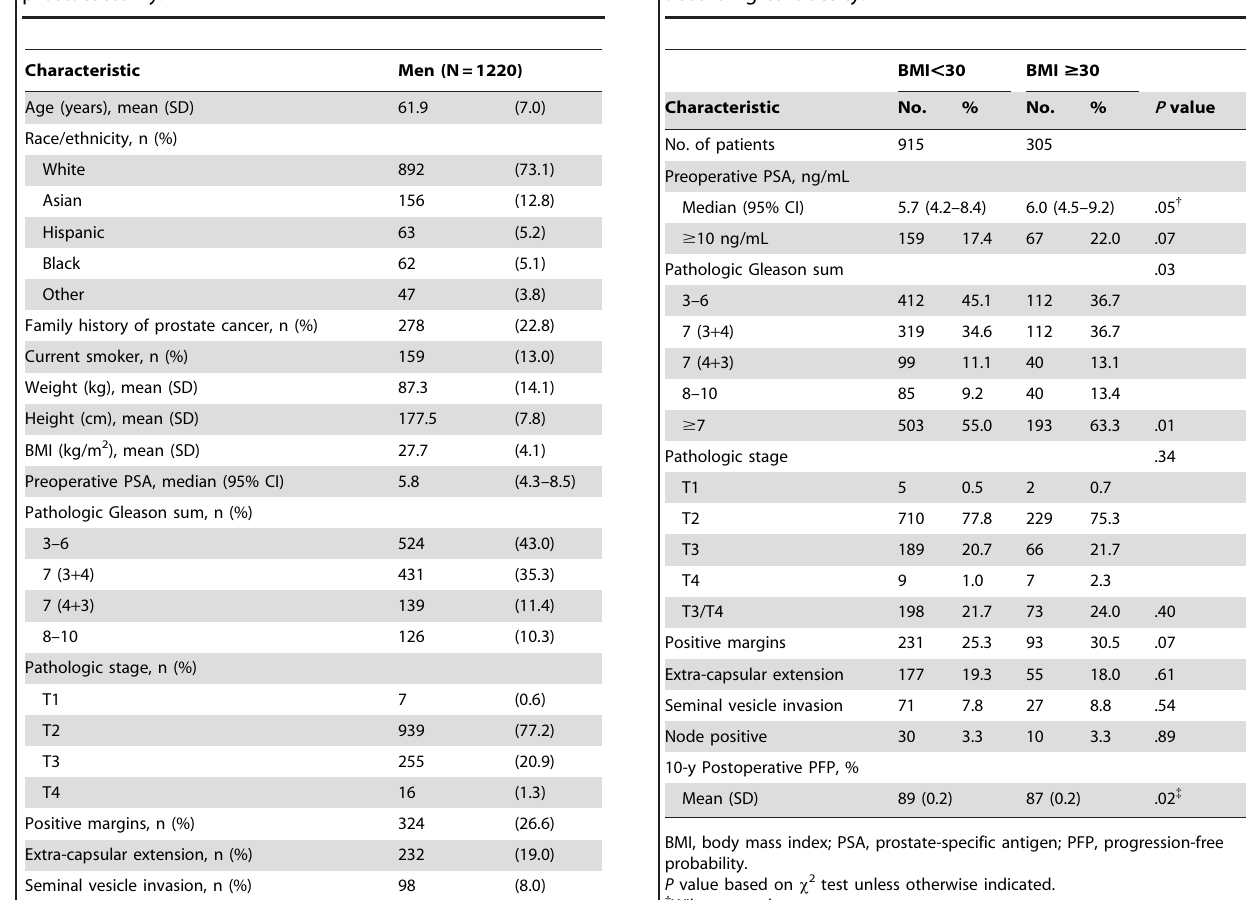
Table 1. Characteristics of patients undergoing radical prostatectomy.